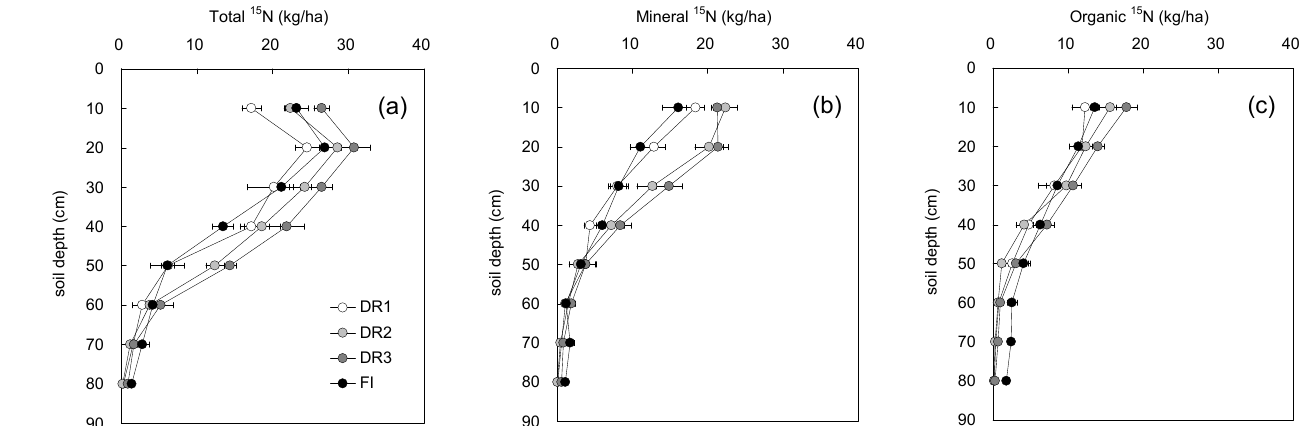
Figure 5. The distribution of total 15 N ( a ), mineral 15 N ( b ) and organic 15 N ( c ) in soil profile after harvest of the succeeding lettuces under different irrigation treatments (DR1, DR2, and DR3 mean the lower irrigation limits of 75%, 65%, and 55% accounting for the field capacity, separately. FI represents furrow irrigation treatment using the same irrigation regime as DR2. The data in the Figure are mean ± SD).